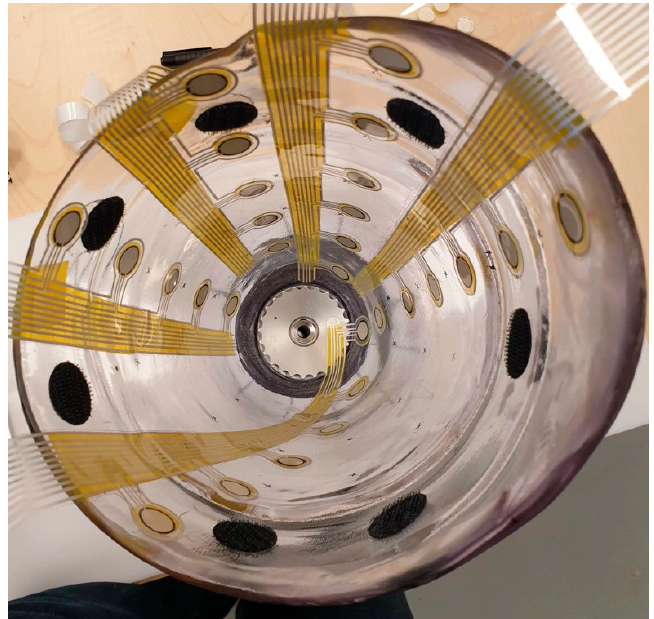
Figure 22. The five QTSS™ pressure sensor strips inside the socket used for the initial pilot trial.